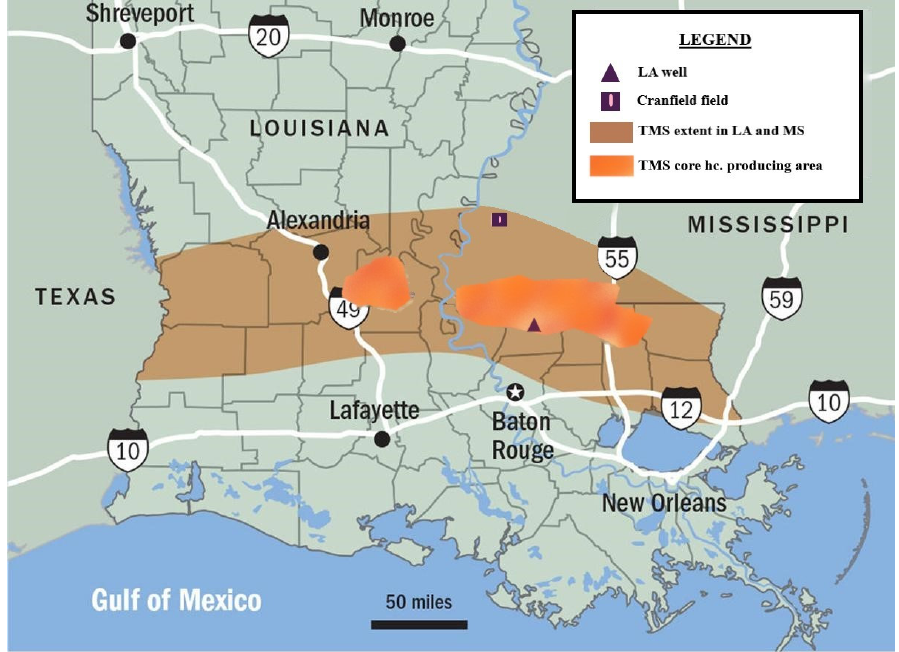
Figure 1. Map showing TMS’ extent in Louisiana and Mississippi, its core hydrocarbon-producing area, and the location of the wells studied.